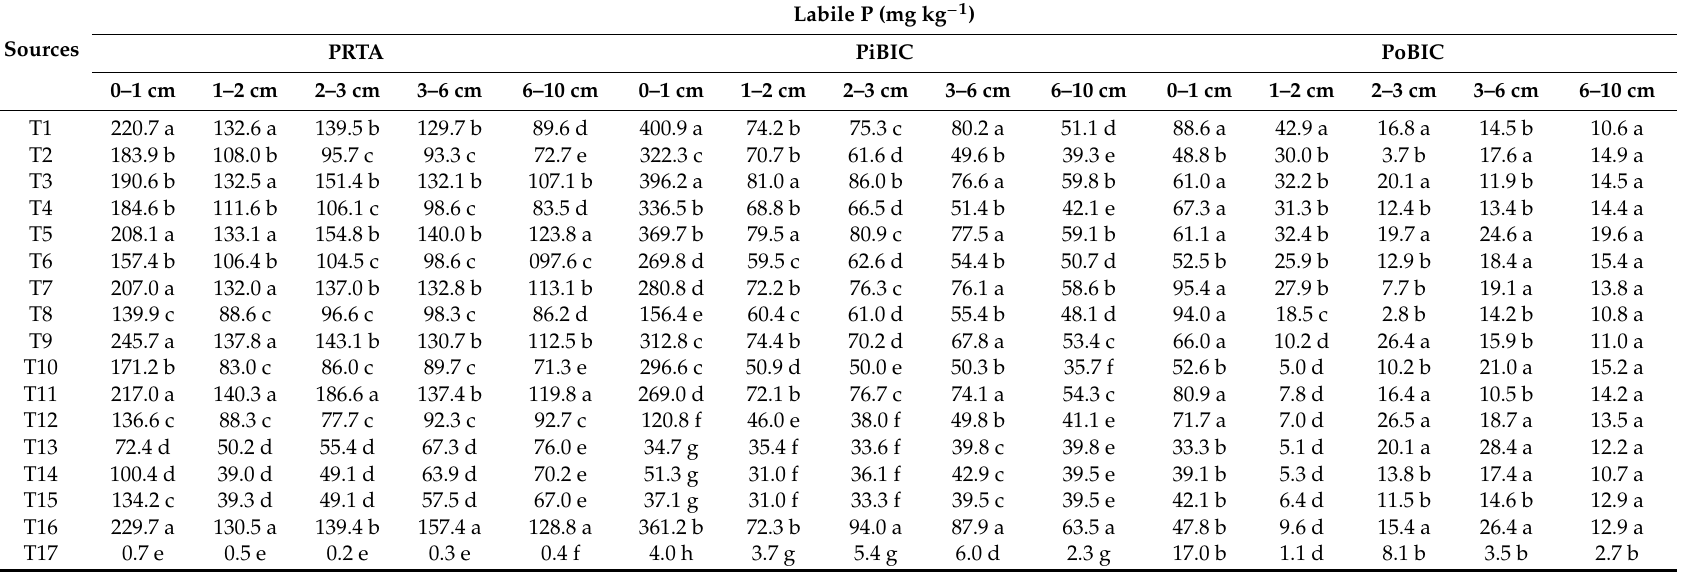
Table A2. Labile fractions of inorganic and organic P in the soil extracted by anion exchange resin (P AER ) and 0.5 mol L − 1 NaHCO 3 (Pi BIC and Po BIC ) in di ff erent layers of the columns according to the sources of phosphate